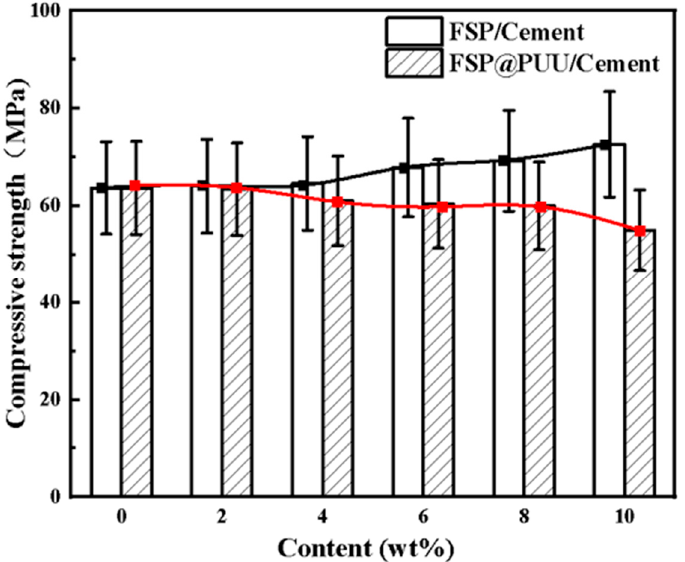
Figure 8. Compressive strength of 20 mm cube specimens for different FSP and FSP@PUU additions.